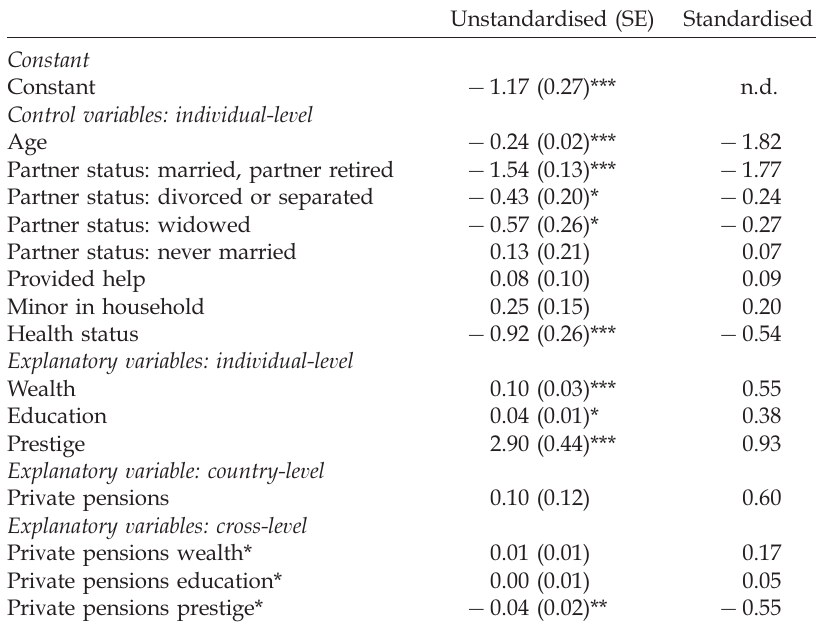
Table 3. Older men’s workforce participation: regression coefficients and standard